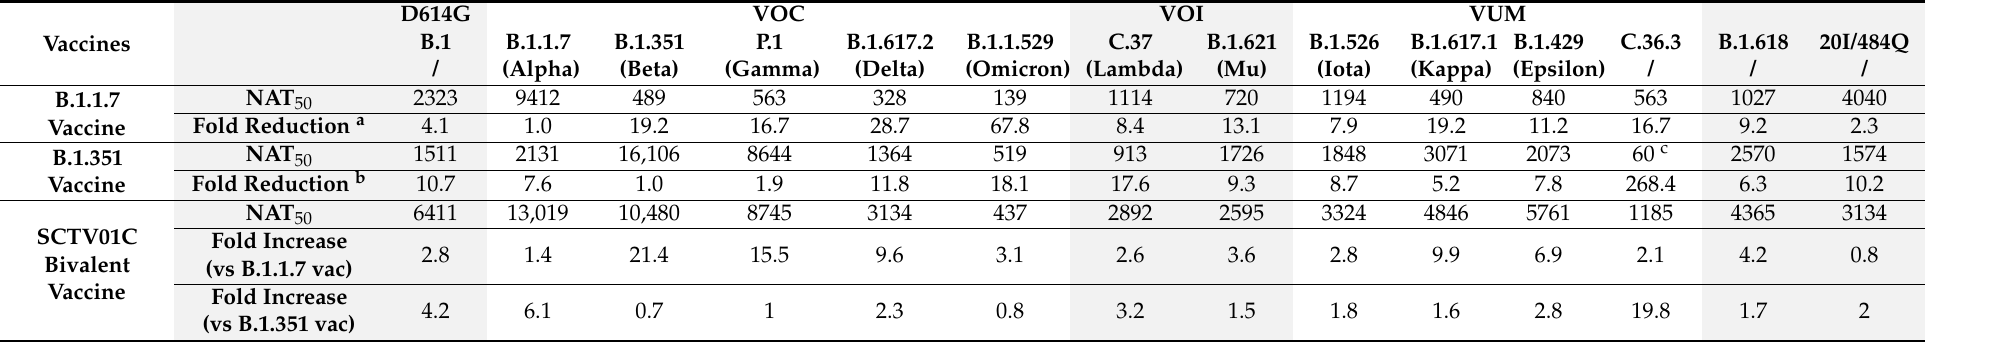
Table 1. PsV neutralizing antibody titer elicited by B.1.1.7 monovalent, B.1.351 monovalent, and SCTV01C bivalent